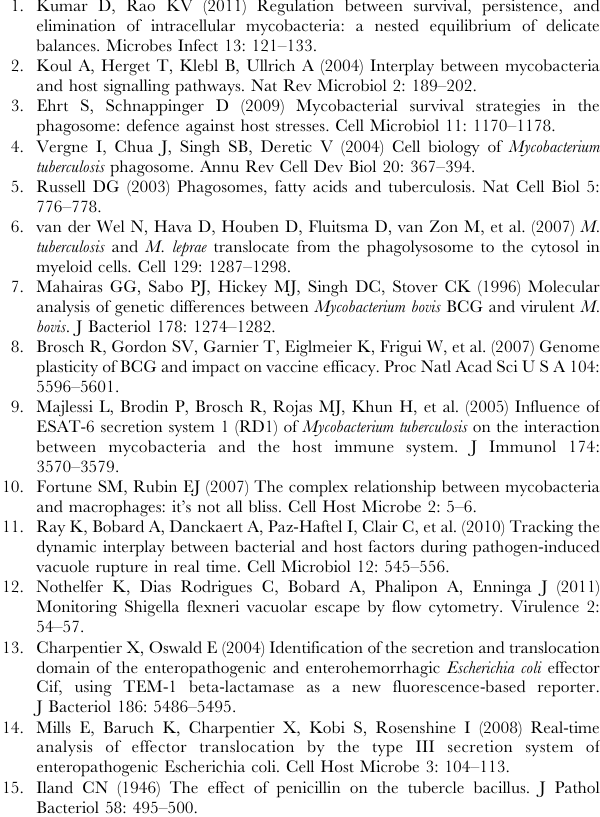
Figure S9 Necrosis induction in BCG or M. tuberculosis infected cells does not result in bacterial contact with host cytoplasm. THP-1 cells were non infected (control) or infected with BCG DsRed or M. tuberculosis DsRed at a MOI of 1 for 2 h. Then, necrosis was induced using 100 m g/ml concanav- alin A for 24 h. Cells were then loaded with CCF-4 molecule for 2 h. After PFA fixation, cells were imaged by fluorescence widefield microscope Nikon Ti with 40X objective.